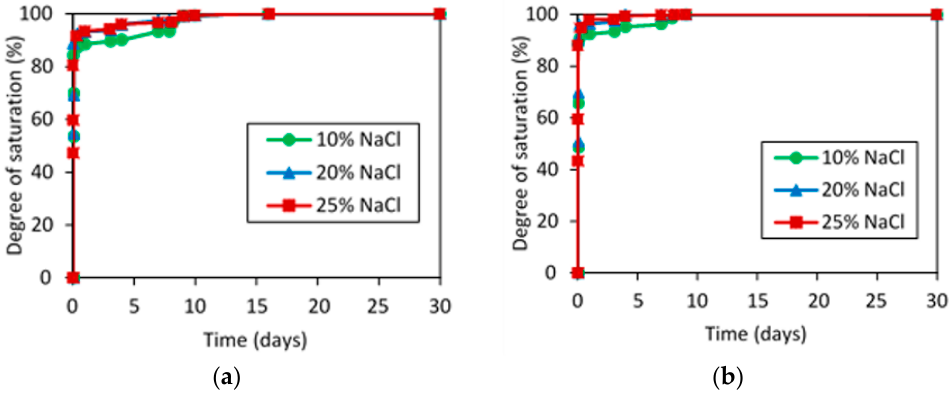
Figure 3. Variation of degree of saturation over time in specimens prepared for ( a ) unconfined compressive strength (UCS); ( b ) splitting tensile strength (STS) tests for varying concentrations of brine (10%, 20%, 25% NaCl).